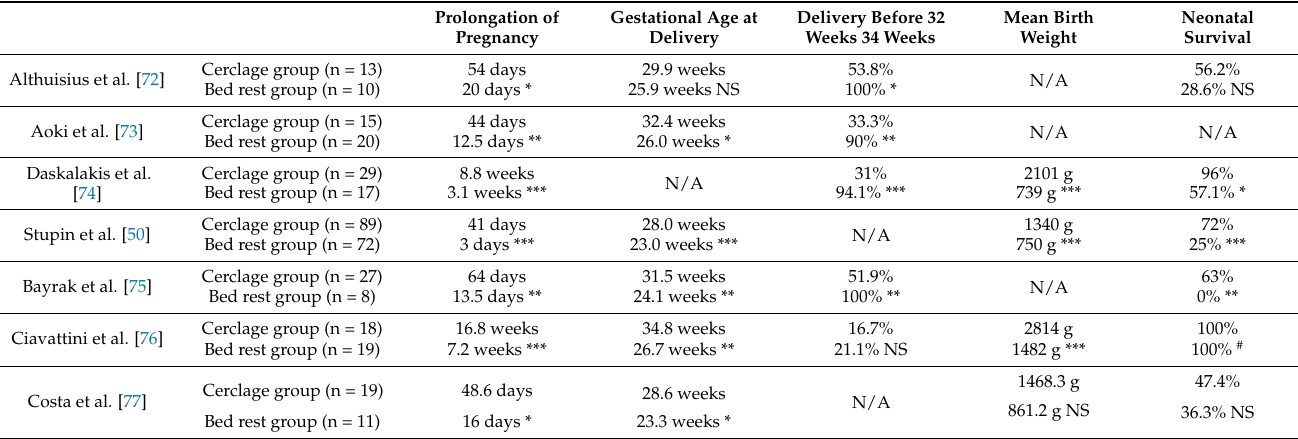
Table 1. Emergency suture